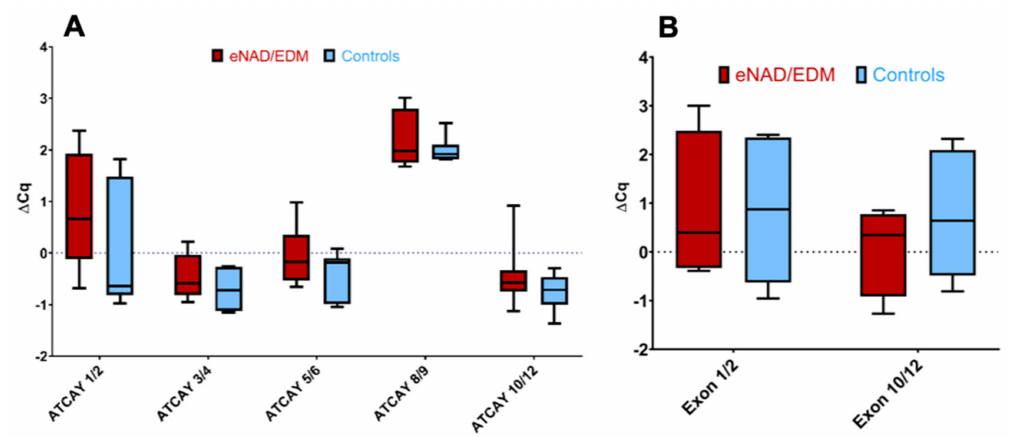
Figure 2. ATCAY expression does not di ff er between confirmed eNAD / EDM horses and controls. ( A ) Each of the five exon pairs tested showed no significant di ff erences between the eight postmortem confirmed cases and seven postmortem confirmed controls. ( B ) Standardization of the cycle threshold ( n = 5 cases and n = 4 controls) between exons 1 and 12 showed no evidence for alternative splicing across the